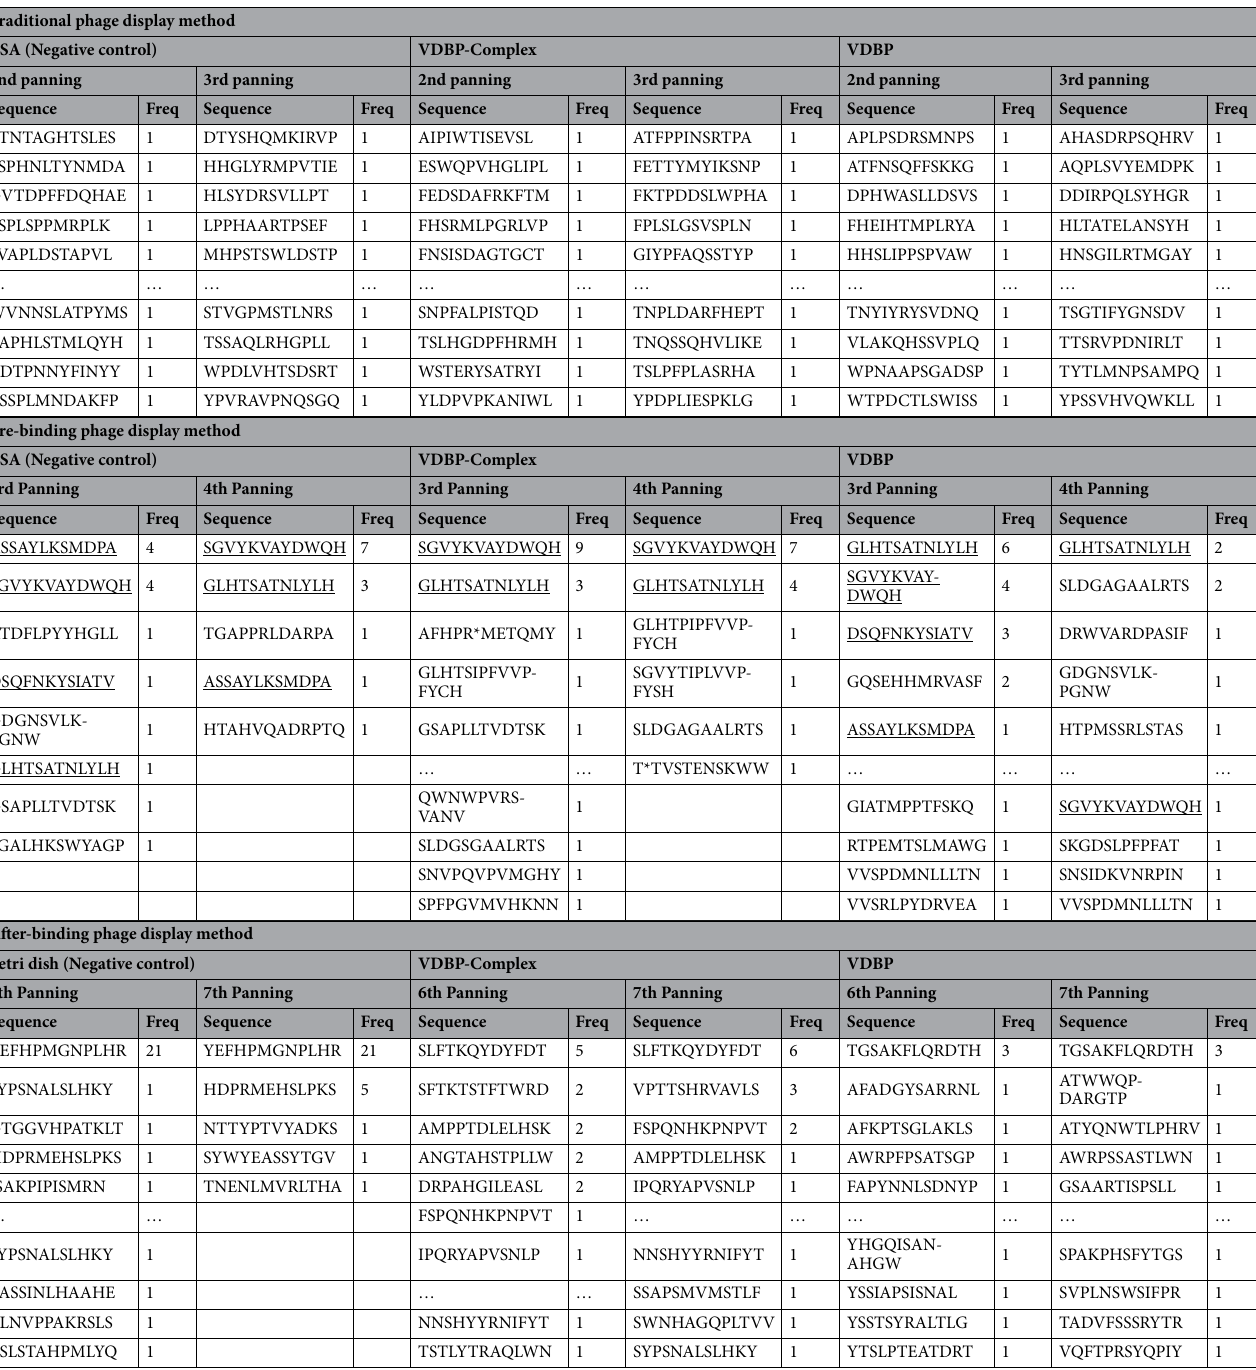
Table 3. DNA sequences analysis data from the two latest biopannings using each phage display method. DNA sequence analysis was performed from the 40 clones for each biopanning. In the pre-binding phage display method, the underlined sequences indicate a sequence that appears simultaneously in the negative control and VDBP-Complex or VDBP. These sequences were ordered by the highest frequency appearance and significance. Freq